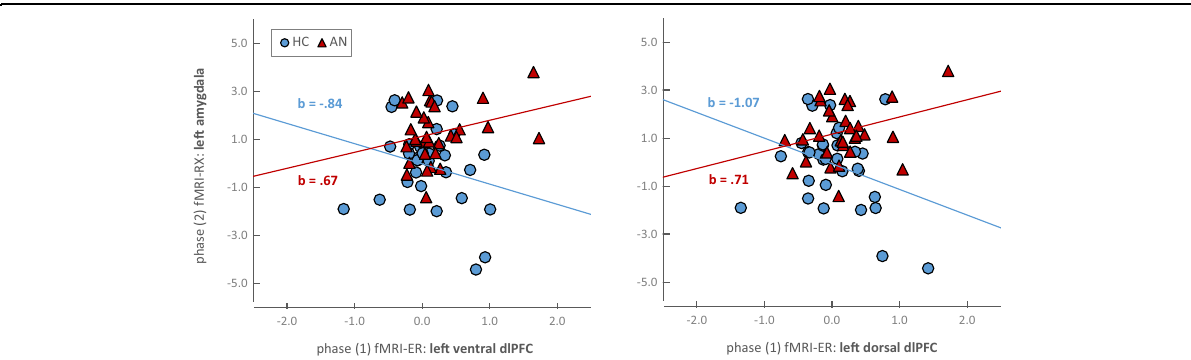
Fig. 1 Prediction of phase (2) fMRI-RX left amygdala activation ( х ̅ RX amygdala_L ) by phase (1) fRMI-ER left ventral dlPFC and left dorsal dlPFC activation ( х ̅ ER dlPFC_Lventral and х ̅ ER dlPFC_Ldorsal ), moderated by group. The linear b coef fi cients were signi fi cantly increased in AN compared to HC (left ventral dlPFC: t (60) = − 2.02; p = 0.048; left dorsal dlPFC: t (60) = − 2.54, p =